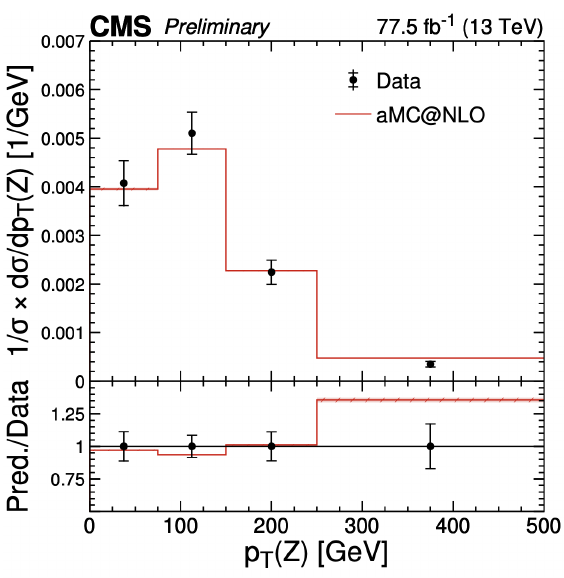
Figure 6. Comparison of normalised unfolded parton − level distribution of the transverse momentum of the Z boson in observed data from CMS [10] with Theoretical expectations obtained from different generators: Sherpa 2.2.1 generator at NLO QCD accuracy using either multi-leg or inclusive setups and MG5_aMC@NLO at NLO QCD accuracy interfaced with either the Pythia or Herwig parton shower